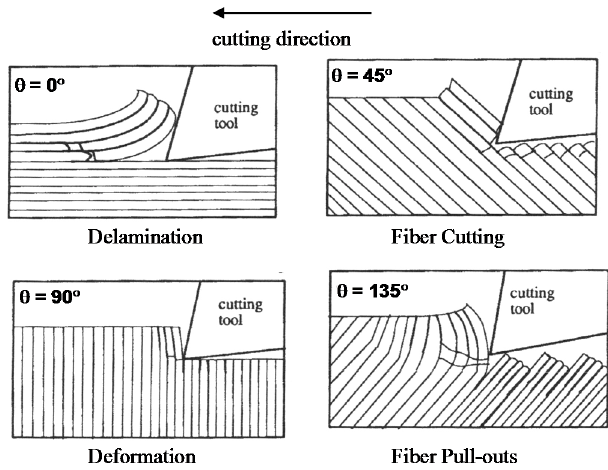
Figure 1. Schematics of CFRP cutting mechanisms depending on fiber orientations [19].